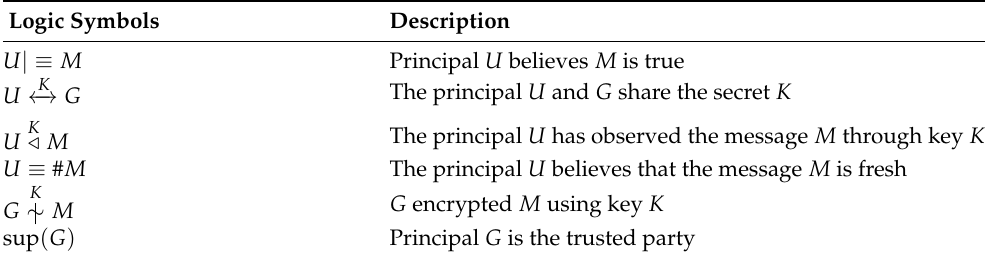
Table 3. Symbols for Mao–Boyd logic and their description. Logic